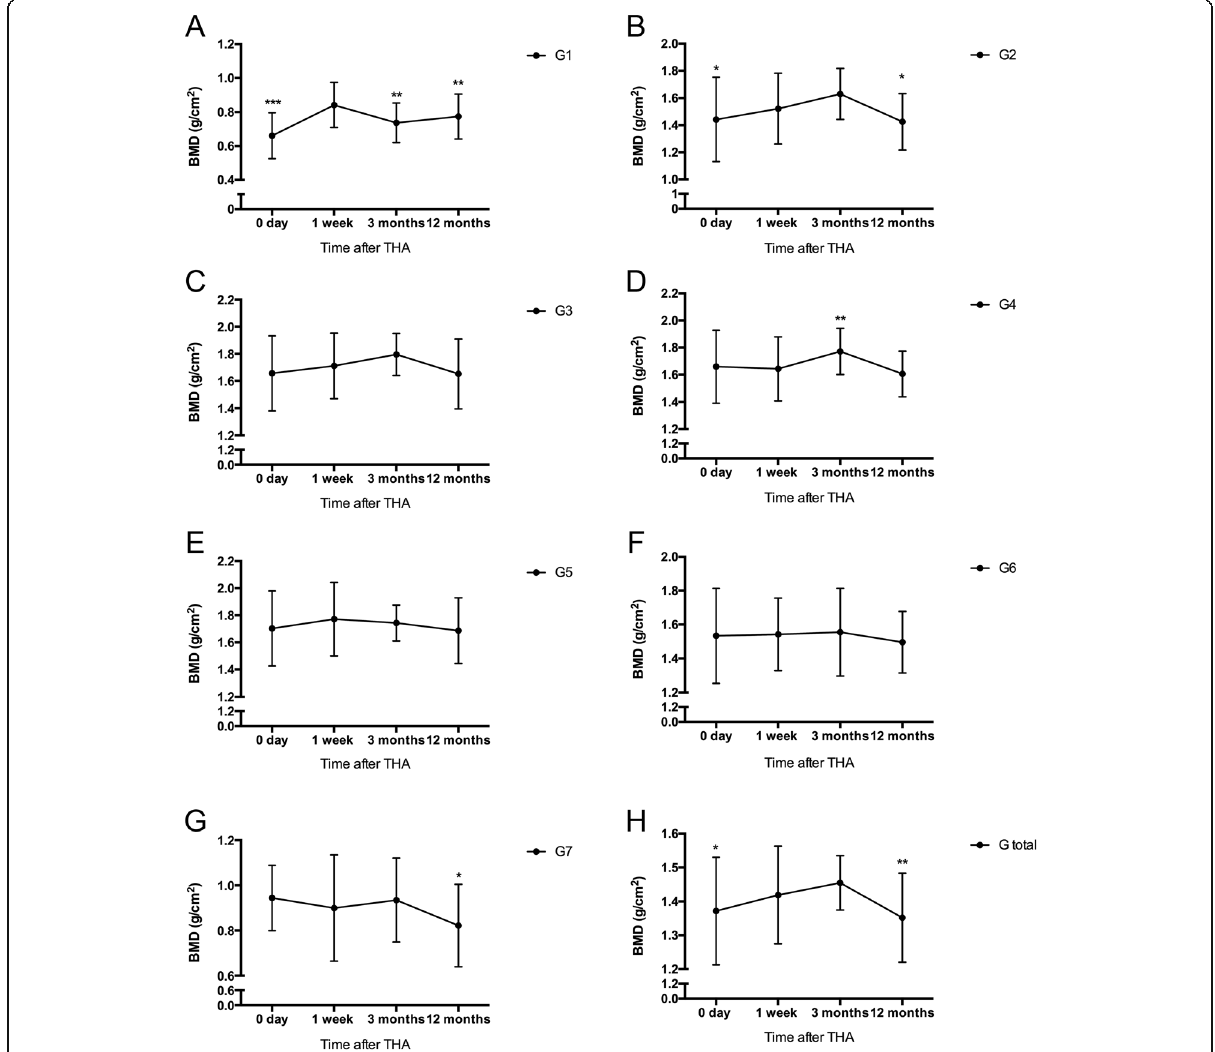
Fig. 2 Comparison of the periprosthetic BMD of 7 Gruen zones and total Gruen zone between the different time points during the follow-up period. * indicated p < 0.05, ** indicated p < 0.01, and *** indicated p < 0.001, when compared with the values measured 1 week after total hip arthroplasty. Comparison of the periprosthetic BMD of Gruen zone 1 to Gruen zone 7 ( a to g ) and total Gruen zone ( h ) between the different time points during the follow-up period. * indicated p <0.05, ** indicated p <0.01, and *** indicated p <0.001, when compared with the values measured one week after total hip arthroplasty